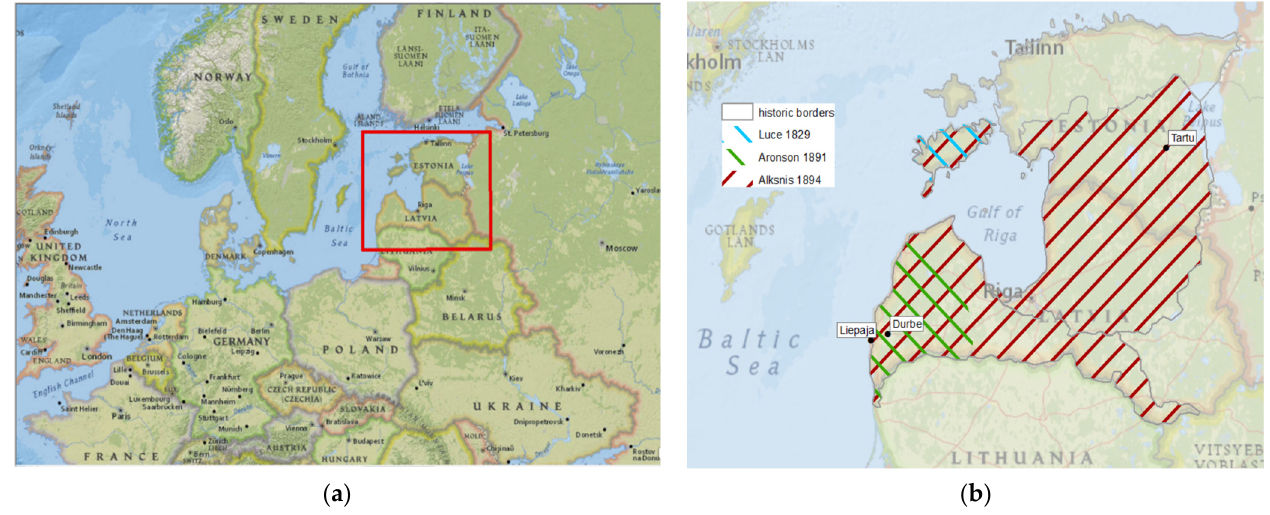
Figure 5. ( a ) Study region within Europe; ( b ) regions where authors worked (ArcGIS, historical borders according to H. Laakmann [65], edited by the second author M.A.).